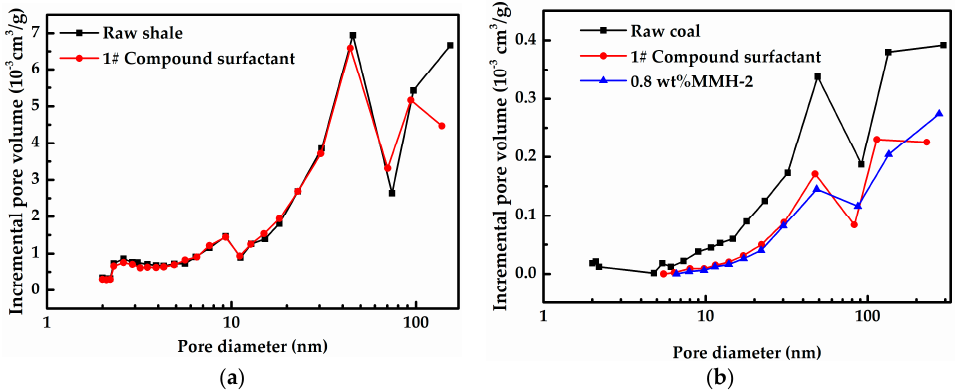
Figure 9. Effect of 0.8 wt%MMH-2 and 1#compound surfactants (0.001 wt% CS-4 + 0.001 wt% CS-1 + 0.001 wt% CS-3) on decreasing pore volume of the Longmaxi shale ( a ) and the Longtan coal ( b ).